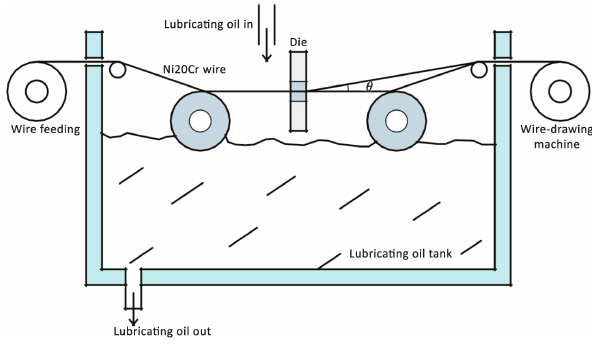
Figure 1: Schematic diagram of cold-drawn from the as-received micro-wire through one